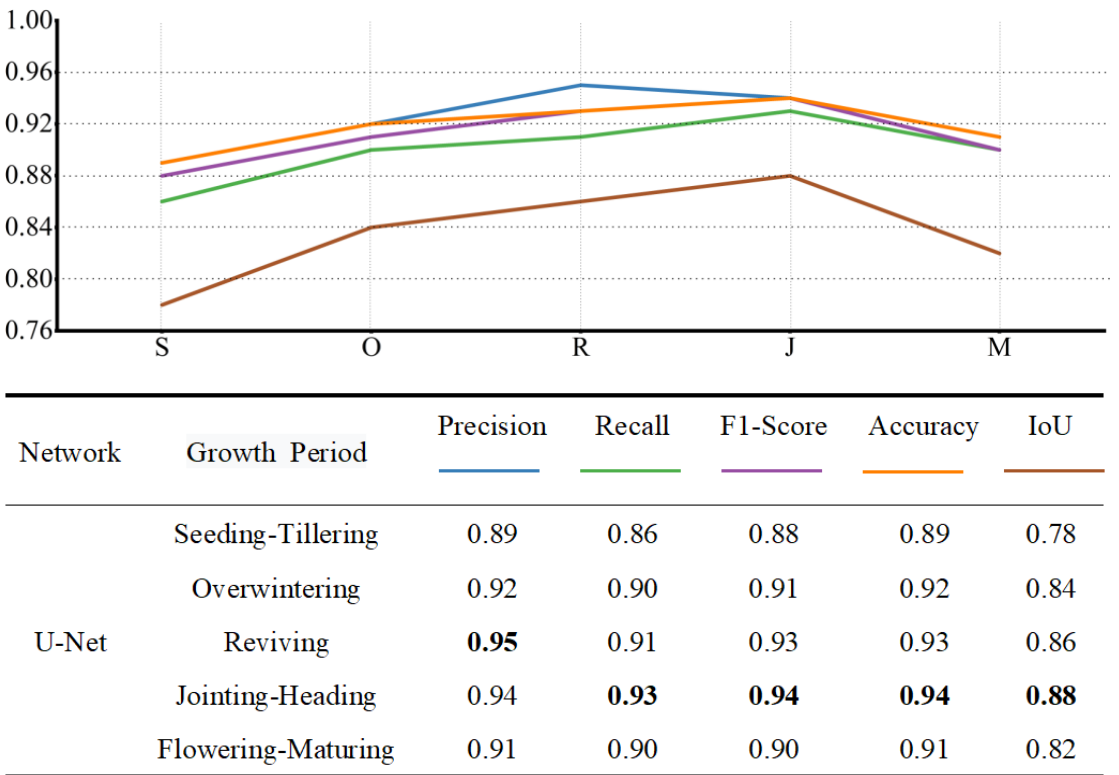
Figure 6. Accuracy of the identification of winter wheat using the test set. S, O, R, J and M represent the seeding‒tillering, overwintering, reviving, jointing‒heading and flowering‒maturing periods, respectively. The numbers in bold indicate the best value for each evaluation index.